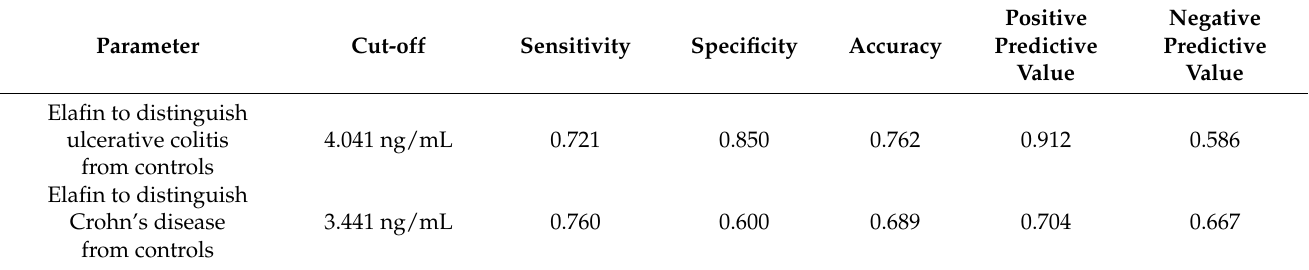
Figure 3. ( A ) ROC curve and area under ROC for elafin in recognition of ulcerative colitis; ( B ) ROC curve and area under ROC for elafin in recognition of Crohn’s disease. Table 2. Diagnostic performance of serum elafin to distinguish IBD from controls.